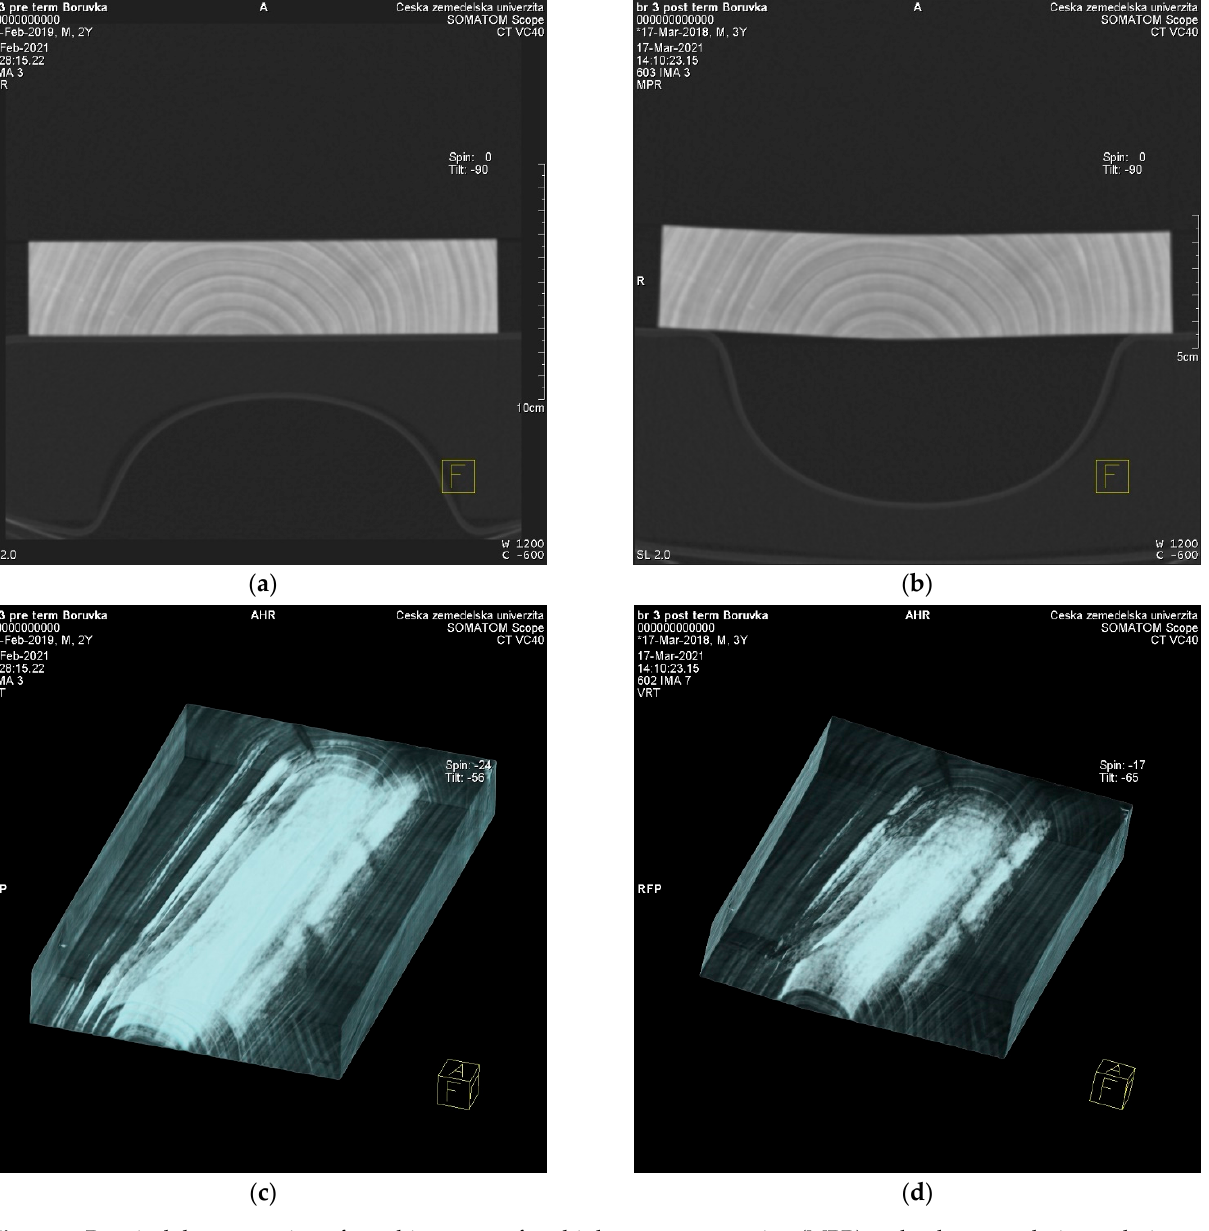
Figure 5. Practical demonstration of graphic output of multiplanar reconstruction (MPR) and volume rendering technique (VRT) of test specimens from scanning on CT Siemens Somatom Scope Power; ( a ) MPR of cross section of the sample before modification, ( b ) MPR of cross section of the sample after modification, ( c ) VRT of the sample before modification, and ( d ) VRT of the sample after modification.